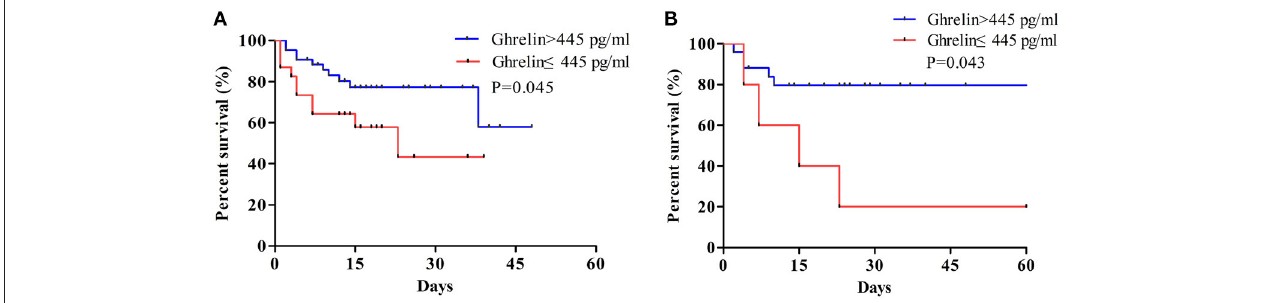
FIGURE 6 | (A) Survival analysis of plasma ghrelin level for sepsis. (B) Survival analysis of plasma ghrelin level in sepsis with ARDS patients. The log-rank test was used to test the difference in survival rate between groups where the plasma ghrelin value was ≥ 445 and < 445